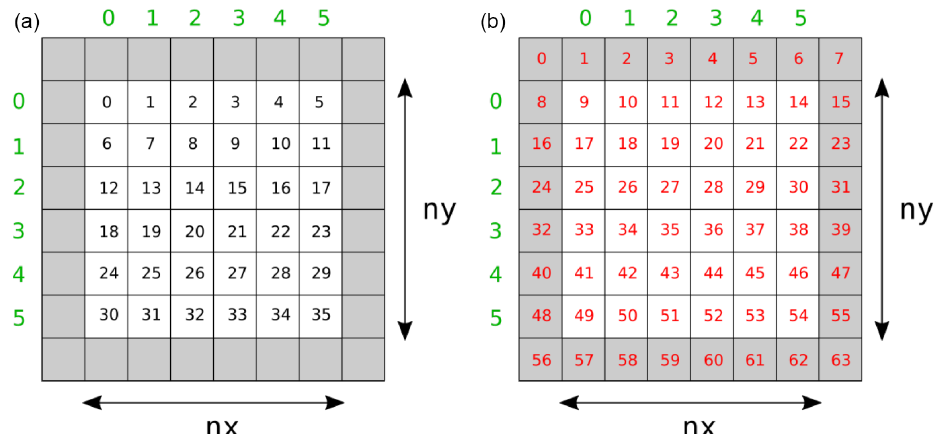
Figure 2. Domain decomposition and indexing in SERGHEI: a subdomain consists of physical cells (white) and halo cells (grey). SERGHEI uses two sets of indices: an index for physical cells (a) and an index for all cells including the halo cells (b) .